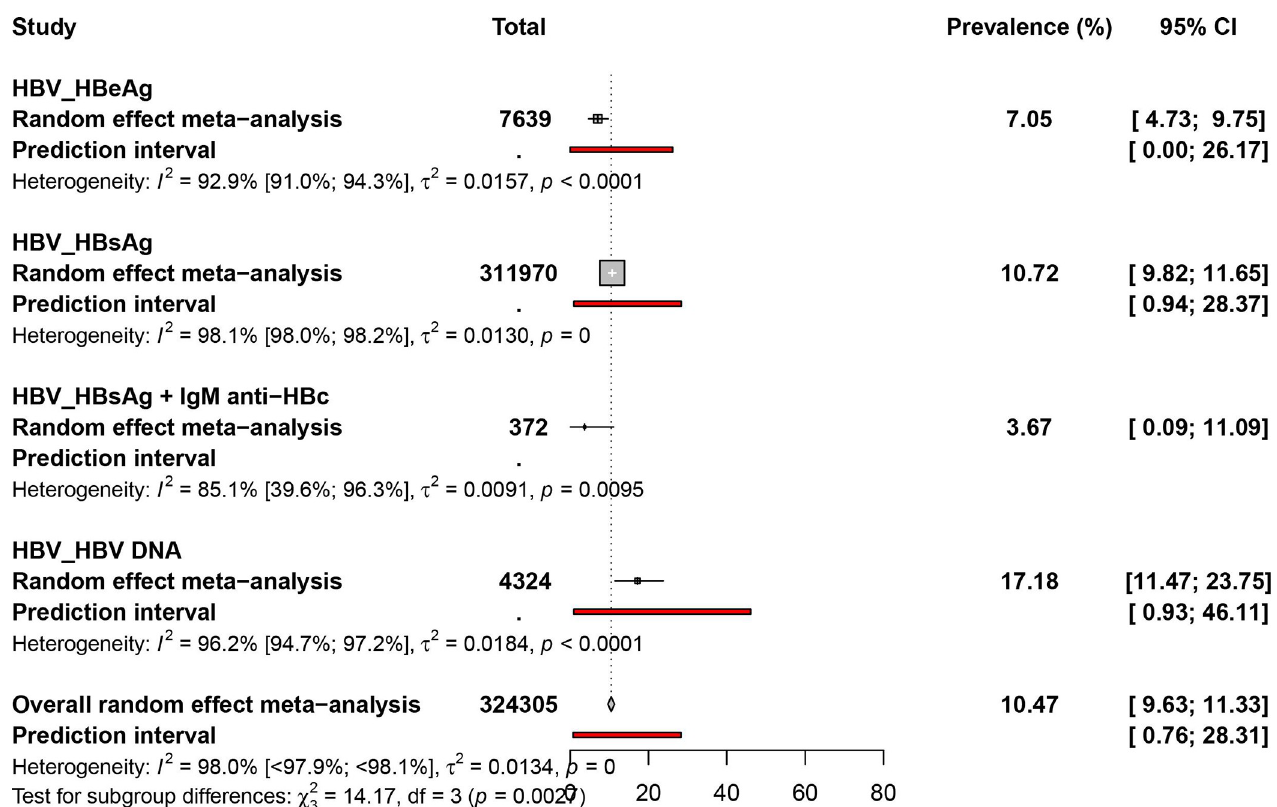
Fig 4. Prevalence estimate of hepatitis B virus infection in PLHIV in Africa.